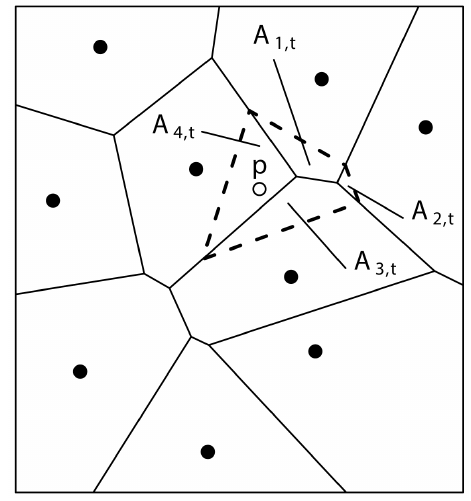
Figure 5. Illustration of the natural neighbour method for time step t . The solid lines represent the original Thiessen polygons T i,j for each of the i rain gauges (solid circle). The dashed line represents the Thiessen polygon ˆ T p,t for the grid point p (open circle). The overlap between T i,t and ˆ T p,t is labelled A i,t ( A i,t = area( T i,t ∩ ˆ T p,t ), Eq.